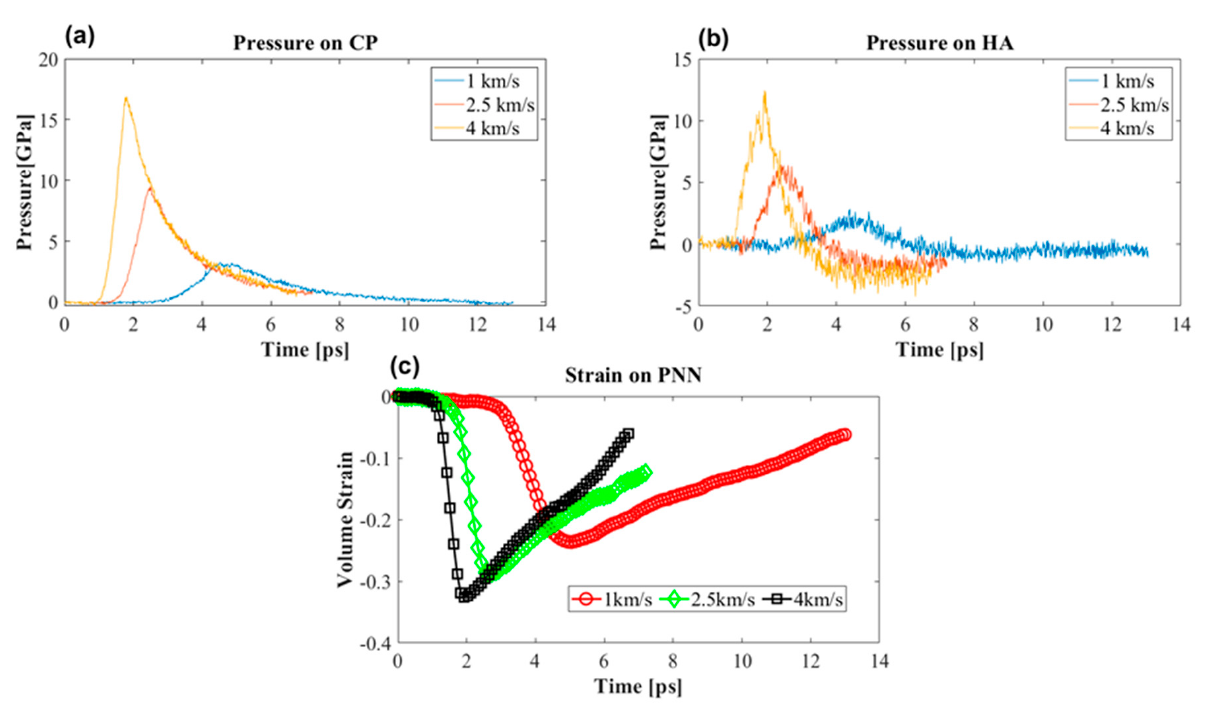
Figure 8. Pressure on the PNN components at different piston speeds. ( a ) Pressure on the core protein (CP). ( b ) Pressure on hyaluronan (HA). ( c ) Volumetric strain on the PNN at different shock speeds.